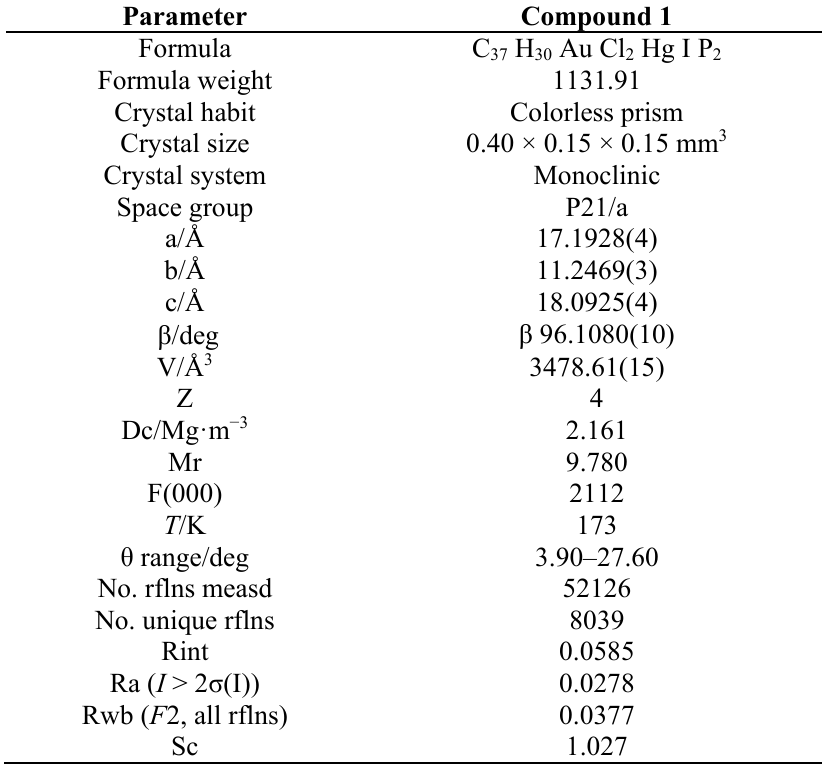
Table 4. X-ray crystallographic data is shown for complex 1